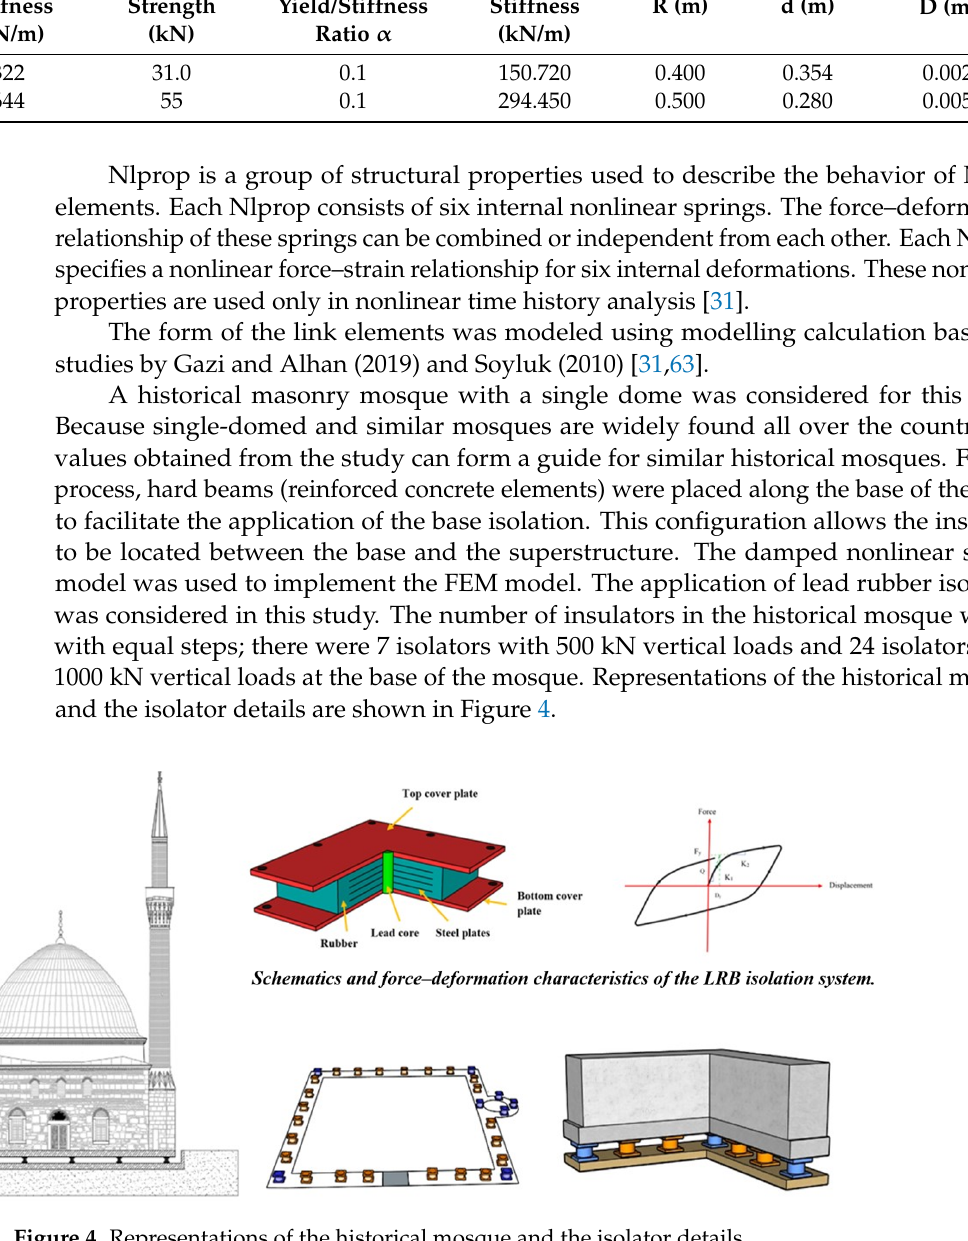
Figure 4. Representations of the historical mosque and the isolator